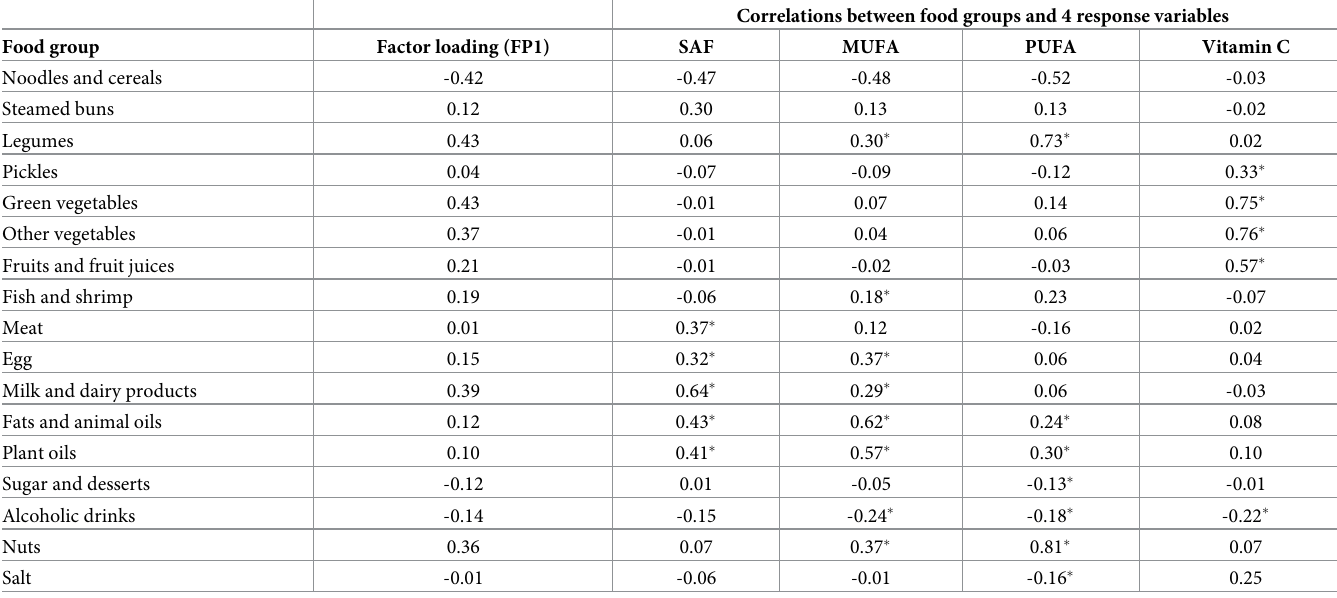
Table 3. Factor loadings of food groups associated with food pattern 1 and correlation coefficients between food groups and four nutrients ( n =